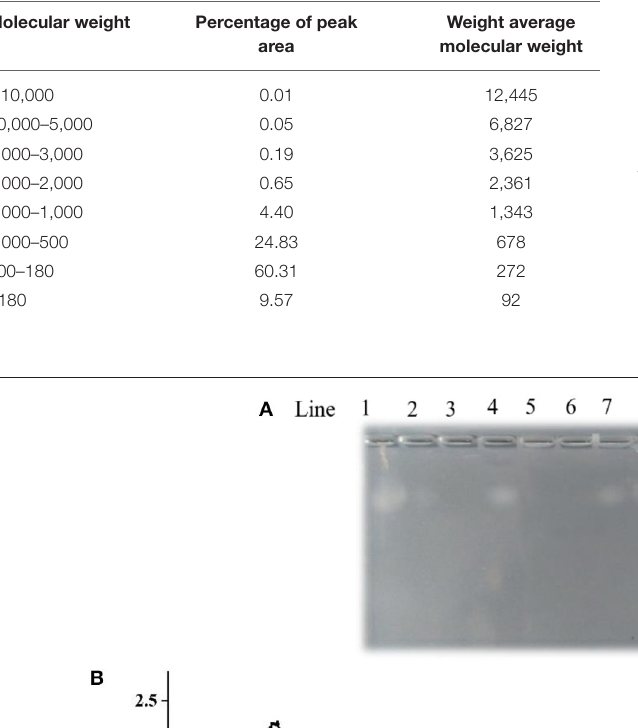
Frontiers in Nutrition |